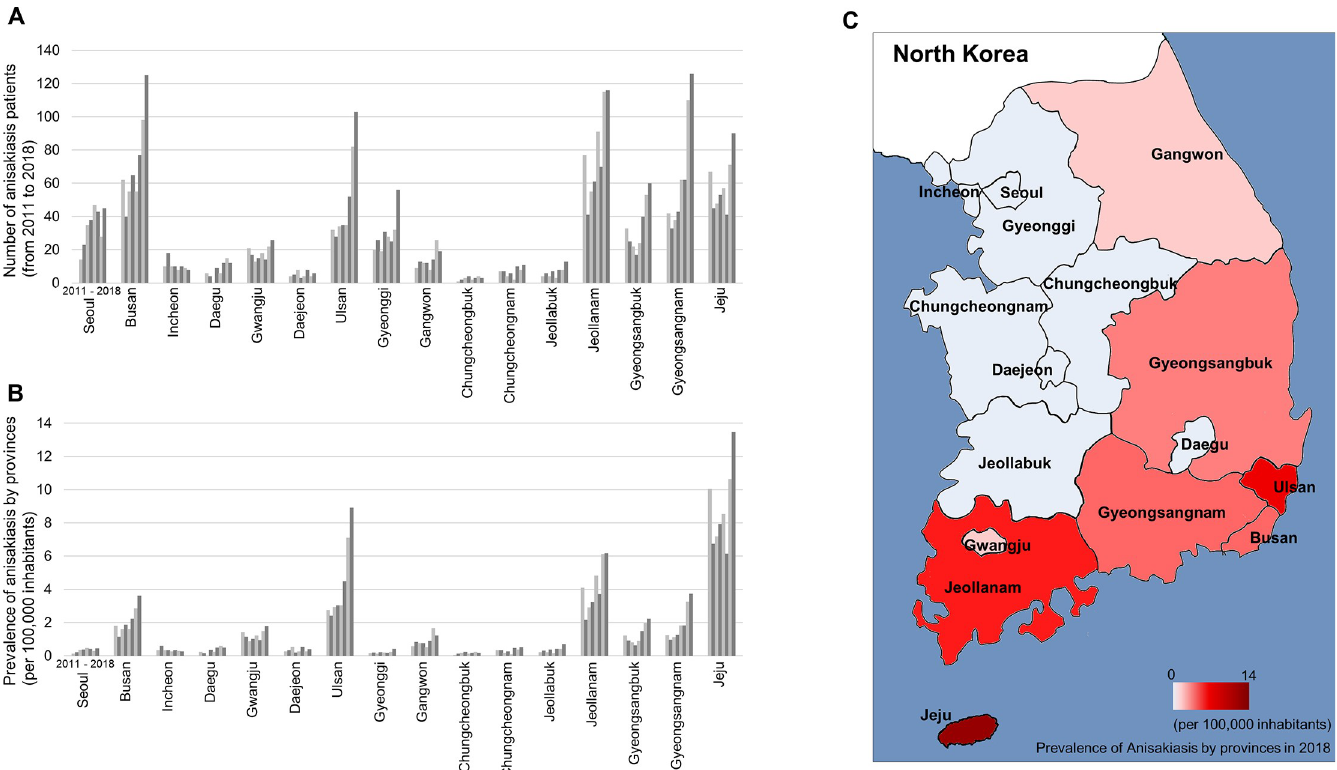
Fig 4. Trend of anisakiasis by province in South Korea. (A) The number of anisakiasis patients from 2011 to 2018. (B) Claims frequency for anisakiasis by province per 100,000 inhabitants from 2011 to 2018. (C) Map of South Korea representing the claims frequency for anisakiasis in 2018 by province. The outline of the map of South Korea was manually drawn, and the map was colored using Microsoft Paint according to the relevant data.